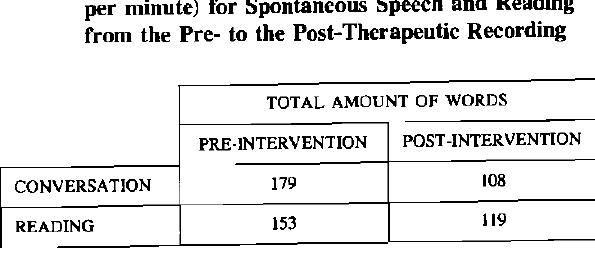
Table 6 Objective Measures of the Rate of Speaking (words per minute) for Spontaneous Speech and Reading from the Pre- to the Post-Therapeutic